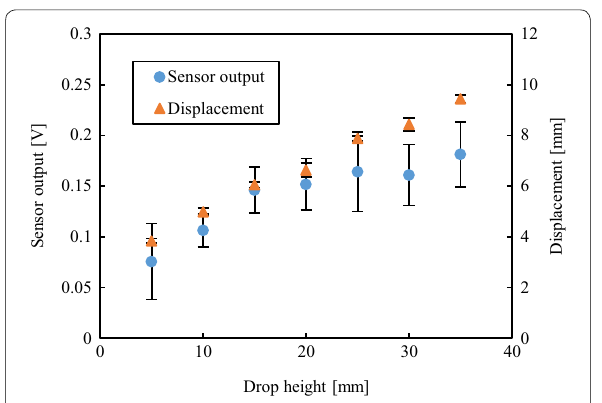
Fig. 10 Relationship between weight drop height and maximum amplitude